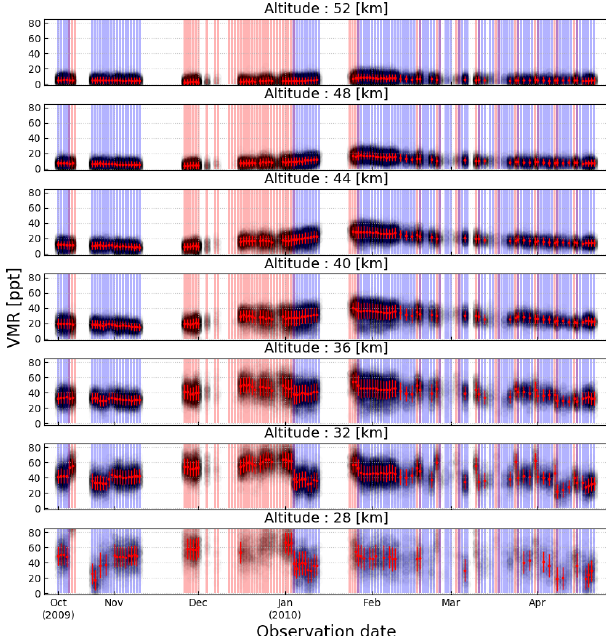
Figure 7. Daily scatterplots and average plots for retrieved CH 3 CN observations at each altitude (28–52km) in the equatorial region (20 ◦ S–20 ◦ N). Solid red lines indicate filtered mean values ob- served on each day. Error bars indicate 1 σ standard deviations. Shaded red (blue) areas represent the date observed by AOS1 (AOS2).